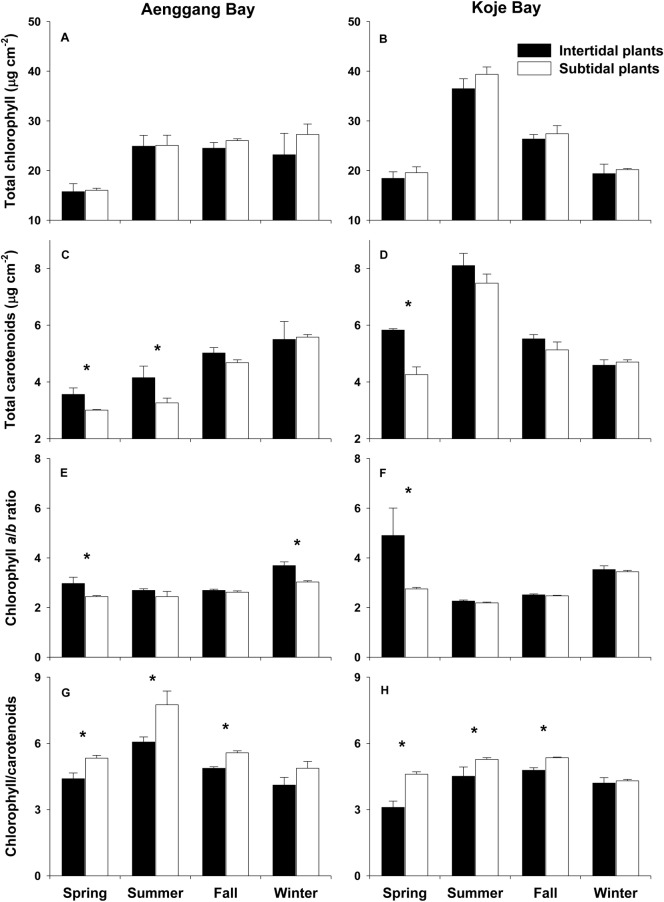
Zostera marina.Photosynthetic pigment concentrations (total chlorophyll and total carotenoids), chlorophyll a/b ratio, and the chlorophyll/carotenoid ratio of the intertidal and subtidal plants in Aenggang Bay (A, C, E, and G) and Koje Bay (B, D, F, and H). Values are means ± standard errors (n = 6). An asterisk above the bar indicates a significant difference between the intertidal and subtidal plants in each season.